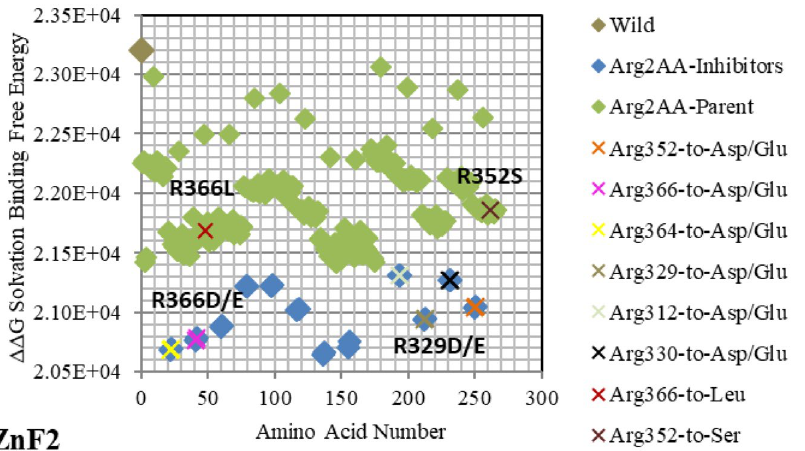
Figure 2. Electrostatic free energy differences of Arginine (Arg/R) within GATA3:DNA complex. Plot presents the solvated binding free energy calculations (in KJ/mol) of GATA3 Arg amino acid mutants in both of Chain-D and Chain-C of the crystal structure 3DFV. Basic and acidic mutants are presented in blue and red colors respectively. Mutants shown above the parent/wild are predicted to enhance binding, whereas mutants shown below it are predicted to reduce binding. Due to its positive charge, Arg/R amino acid does not lead to acidic mutants. The x-axis (index) represents the order of the mutant (mutants are numbered and ordered interactions they